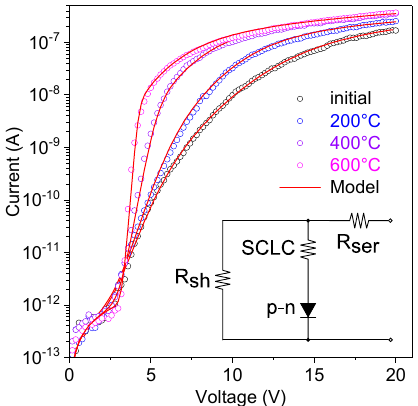
Figure 9. Experimental (symbols) and theoretically fitted (solid line) forward bias I – V curves for the annealed single nanorod ZnO / GaN heterojunction on the FIB-patterned substrate. The inset shows the equivalent electrical circuit of the single nanorod heterojunction used for the fitting.